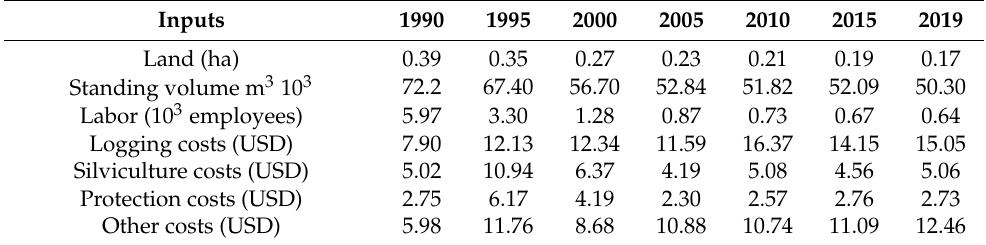
Table 2. Inputs per 1 m 3 of timber produced by the Polish State Forests in 1990–2019.